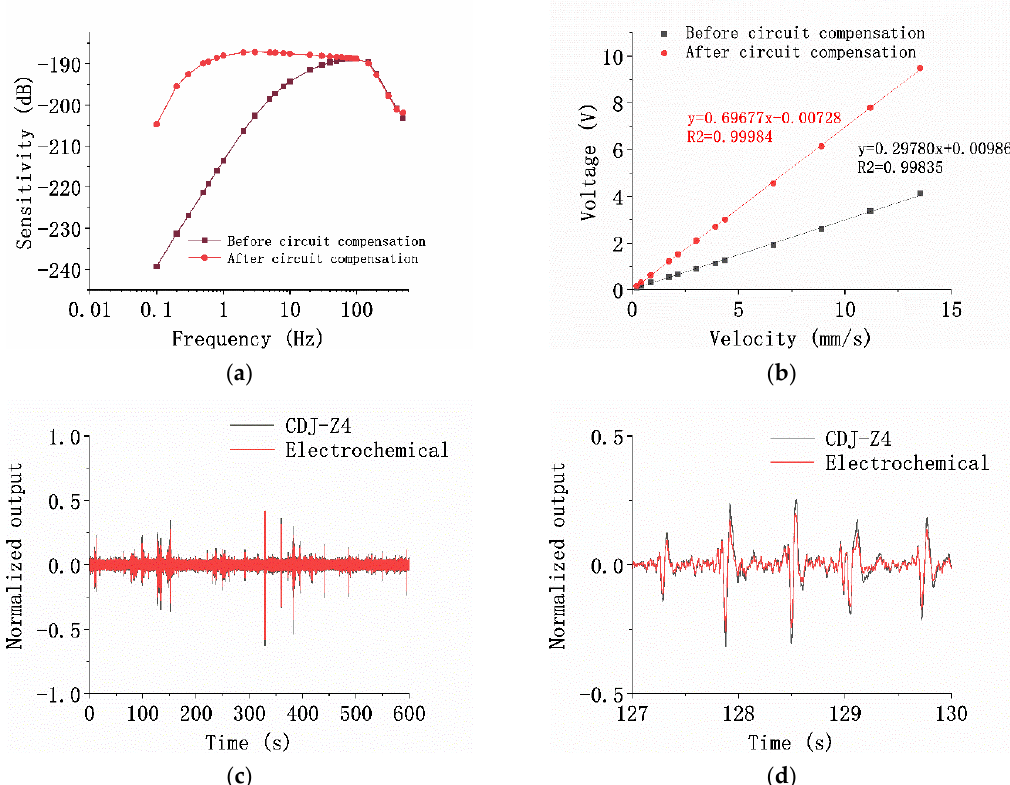
Figure 6. Test results of the sensitive structure of the MEMS electrochemical vector hydrophone. ( a ) Sensitivity curves of the device before (black curve) and after the circuit compensation (red curve); ( b ) linearity test results of the device at 10 Hz; ( c ) comparison test results between the electrochemical vector hydrophone sensitivity unit and the moving ‐ coil detector CDJ ‐ Z4; ( c ) the normalized time ‐ domain response of the electrochemical vector hydrophone sensitivity unit and the moving ‐ coil detector CDJ ‐ Z4 are compared; ( d ) the enlarged view of the normalized time ‐ domain response from 127 to 130 s.